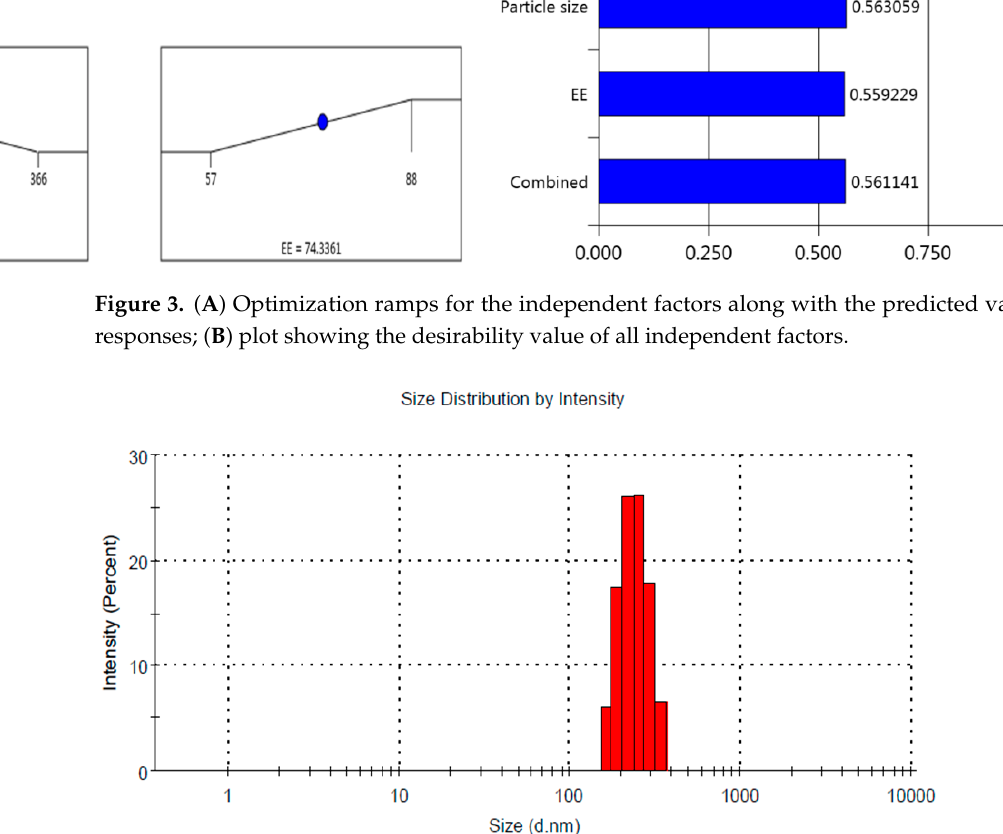
Table 2. Predicted versus observed value of the optimized FA-SLN formulation.